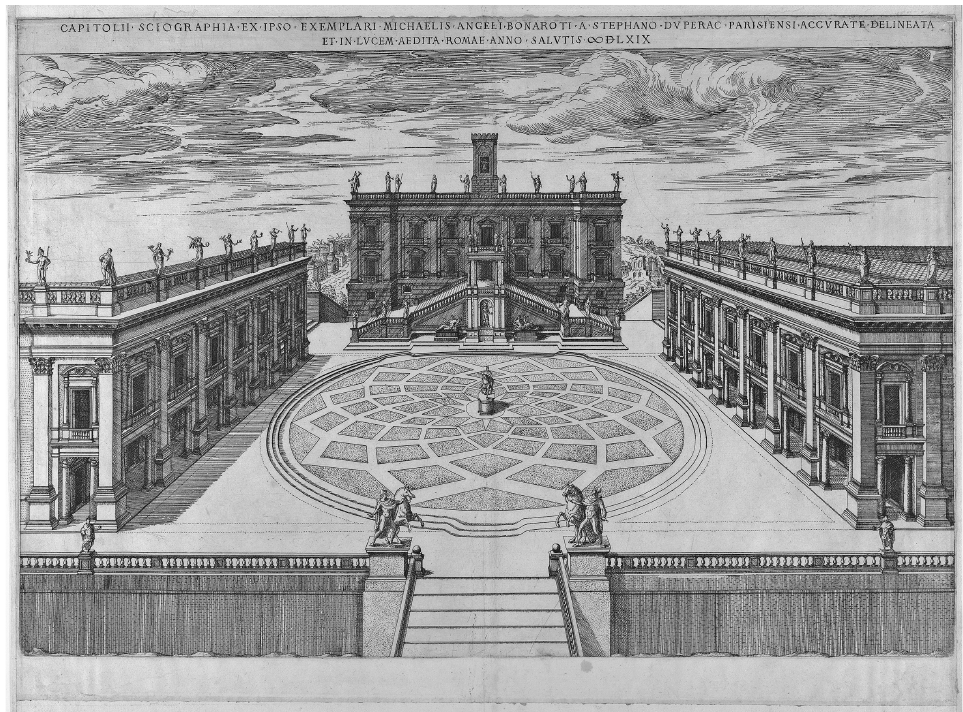
Figure 3: Engraving: Design for the Capitoline Hill by Etienne DuPérac, 1569 ( Speculum Romanae Magni fi centiae , Metropolitan Museum of Art www.metmuseum.org